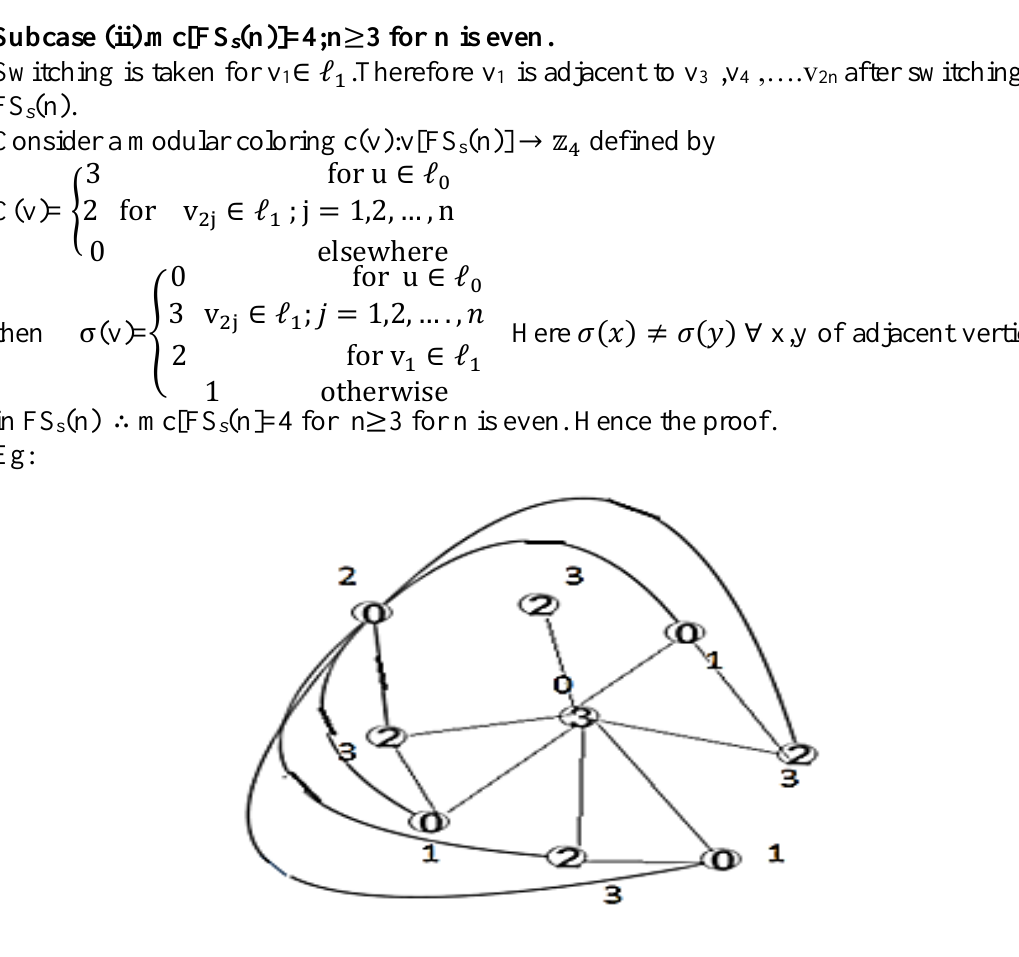
Figure 15 . Switching with modular coloring in